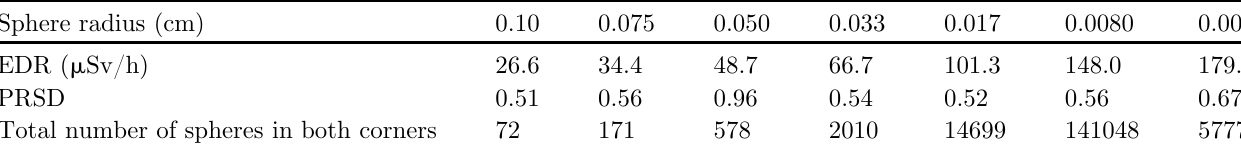
Table 2. RSA spherical inclusion method, equivalent dose rate (EDR) calculated for different values of the radius of the source spheres.